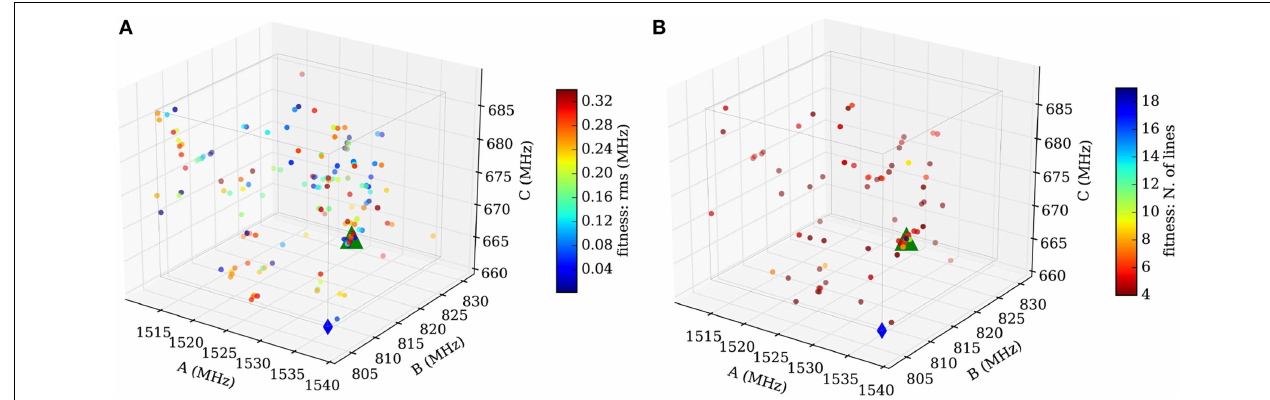
FIGURE 10 | Results for the subcube shaded red in Figure 9. (A) Sample distribution after the fit employing SPFIT (step 2). The samples are color-coded using the value of the standard deviation provided by SPFIT. A subtle convergence toward the measured value (green triangle) is visible. (B) Sample distribution after evaluation of the fitting results (step 3). The samples are now color-coded using the number of assigned lines of the SPCAT prediction. The concentration of many